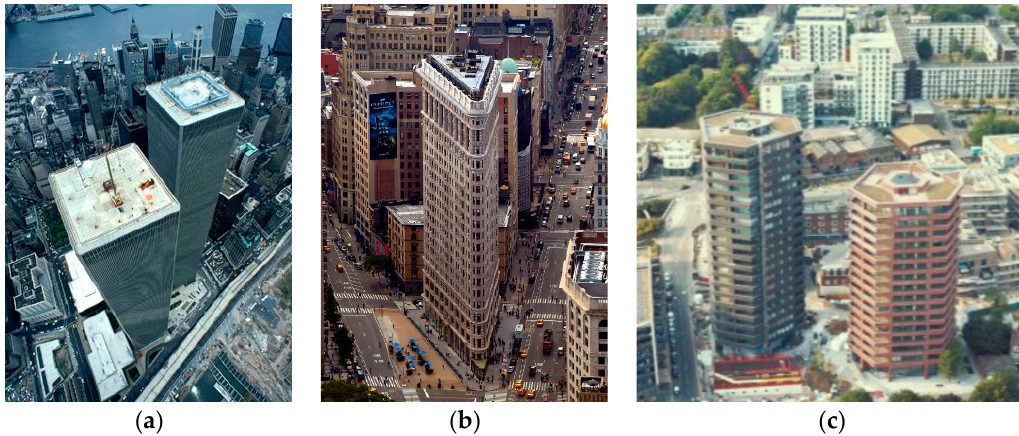
Figure 2. Three example pictures of: ( a ) rectangular plan building (WTC buildings, New York, USA) [23], ( b ) triangular plan building (Flatiron Building, New York, USA) [24] and ( c ) hexagonal plan (Hoxton Press towers, London, UK) [25]. Table 1. Terminology of models .